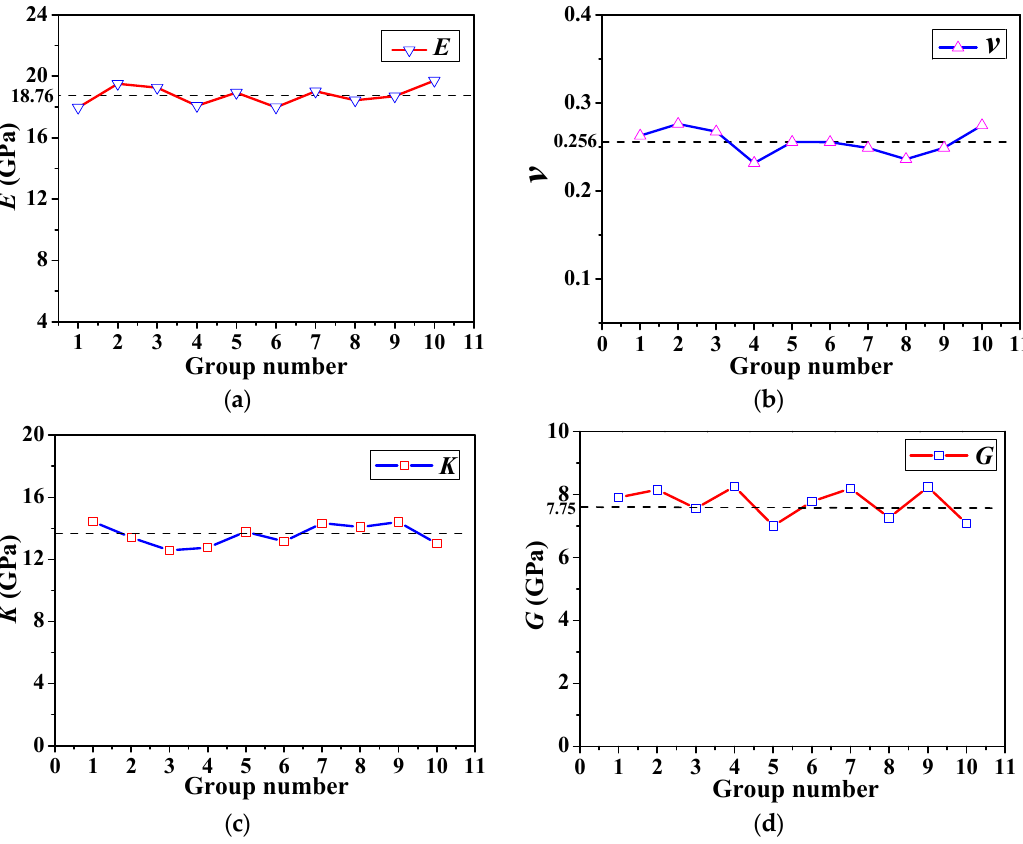
Figure 7. Changes of ( a ) the tensile modulus ( E ), ( b ) the Poisson’s ratio ( v ), ( c ) the bulk modulus ( K ) and ( d ) the shear modulus ( G ) of 10 groups of repeated simulation calculated using the COMPASS force field.